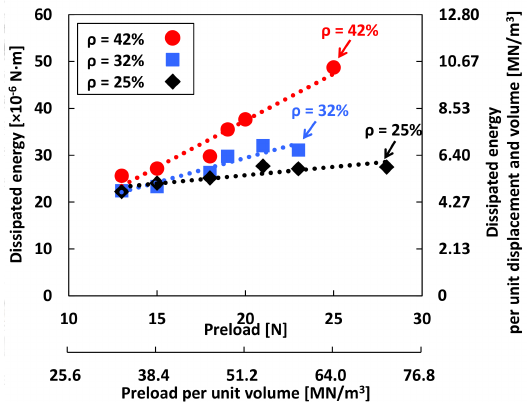
Figure 11. Local hysteresis loop measurements: Dissipated energy E dis (left vertical axis) and dissipated energy E dis per unit displacement and volume of WMD (right vertical axis) versus preload F Pre (upper horizontal axis) and versus preload F Pre per unit volume of WMD (lower horizontal axis). The circle, square, and diamond symbols denote the dissipated energies of the WMDs with 42%, 32%, and 25% densities,